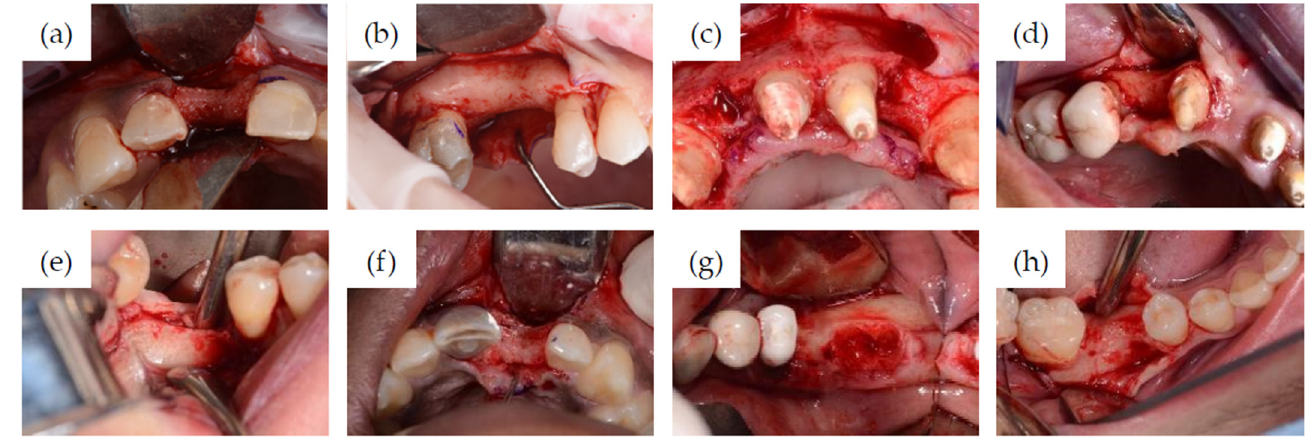
Figure 3. Selected clinical views of implant recipient sites after full-thickness flap elevation ( a – h ). ( a , b ), flap elevation in patients shown in Figure 2a,b, respectively.